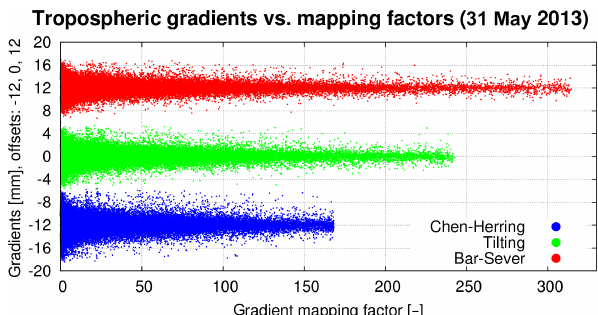
Figure 1. Variability of gradient mapping factors and tropospheric gradient contributions expressed in azimuths of individual satellites. Three mfg were studied on 31 May 2013: Chen and Herring mfg (blue), Bar-Sever mfg (red) and tilting mfg